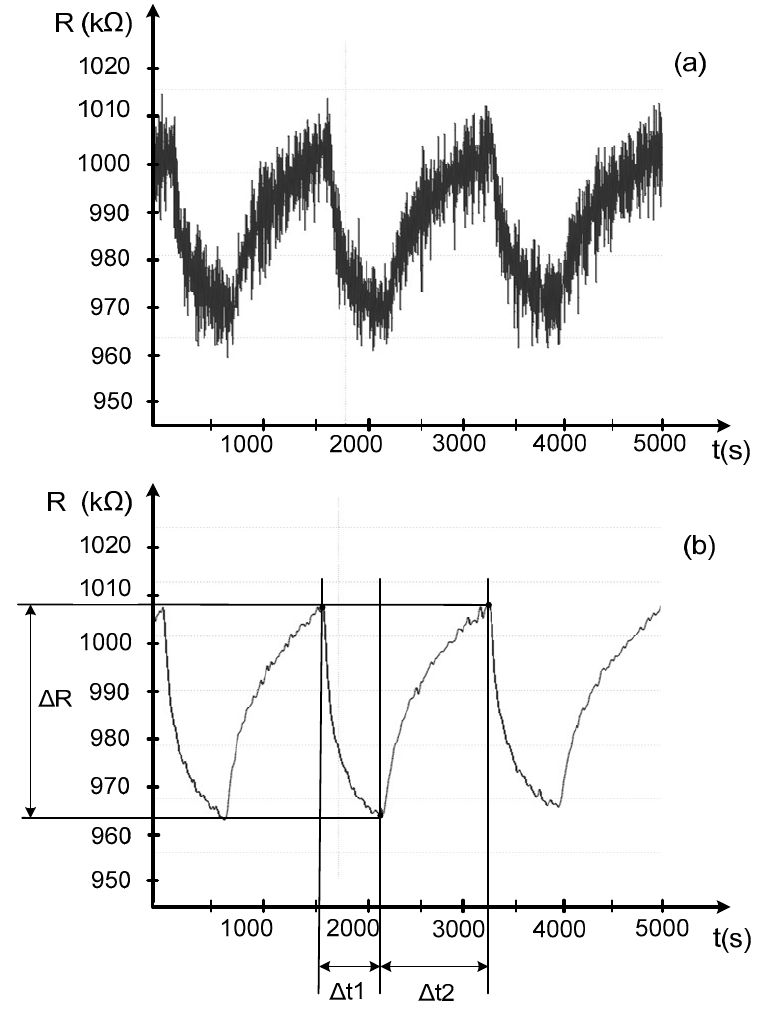
Figure 2. The graphs of ( a ) the original signal and ( b ) the filtered signal (sensor working temperature, 80 °C).